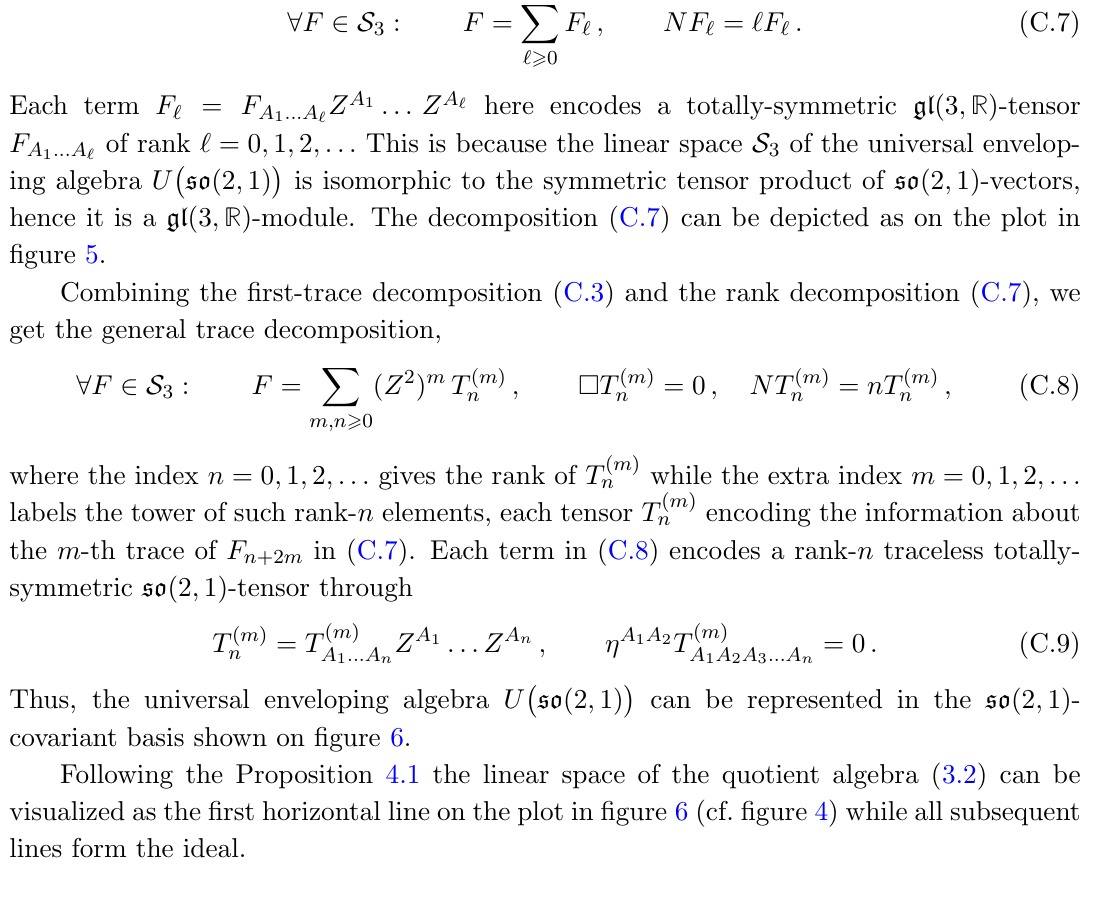
so (2 ; 1) . (cid:0) (cid:1)